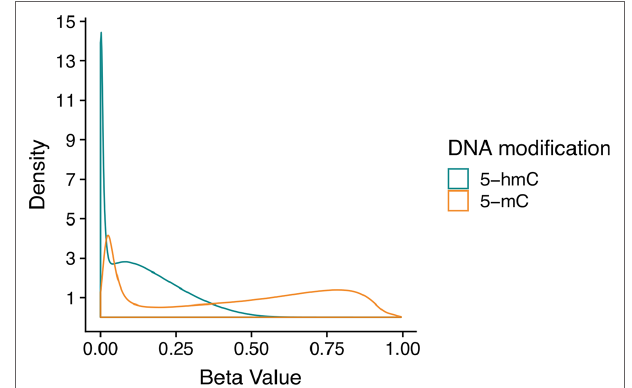
FIGURE 2 | Beta value distributions for 5-mC and 5-hmC from example BS-EPIC/oxBS-EPIC array data. Beta values for 5-mC and 5-hmC were estimated from in-house example BS/oxBS-EPIC data using the oxBS.MLE function with default parameters in the ENmix R package. Since many CpG sites have appreciable 5-mC, but no 5-hmC, estimated 5-hmC beta values are zero-enriched after maximum likelihood estimation from BS/oxBS